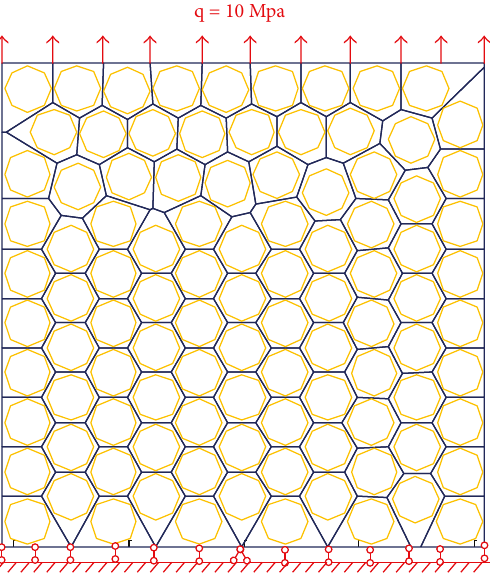
Figure 2: A RVE with 100 inclusions.